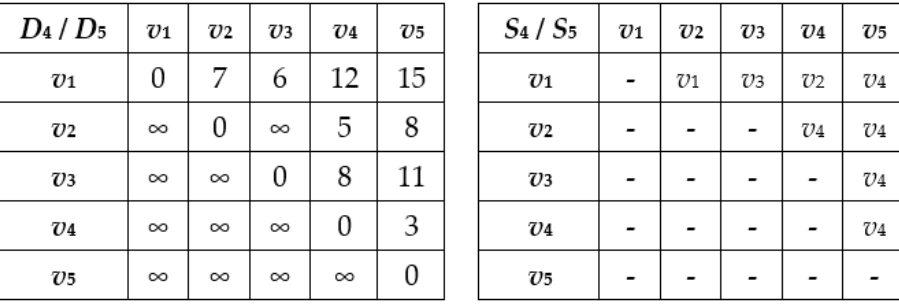
Figure 7. Matrices D 5 and S 5 at the fifth iteration.